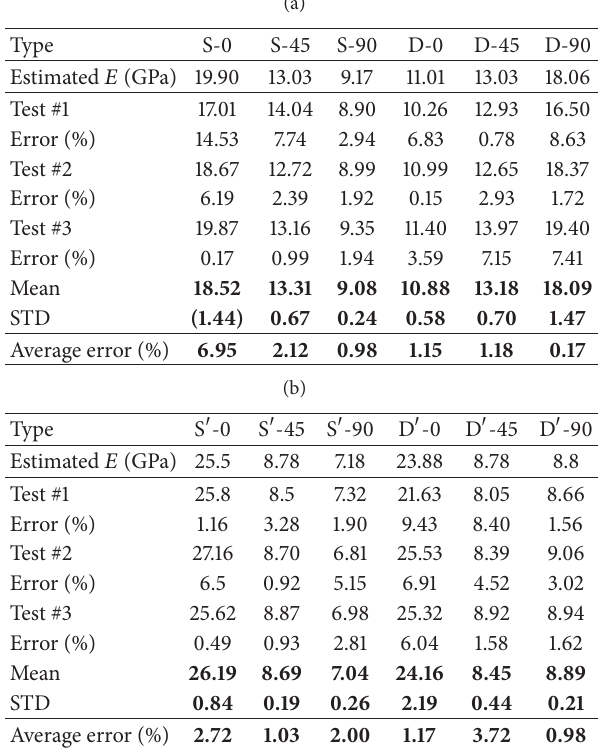
Table 3: The estimated and measured elastic modulus of the 4-layer strip composites.